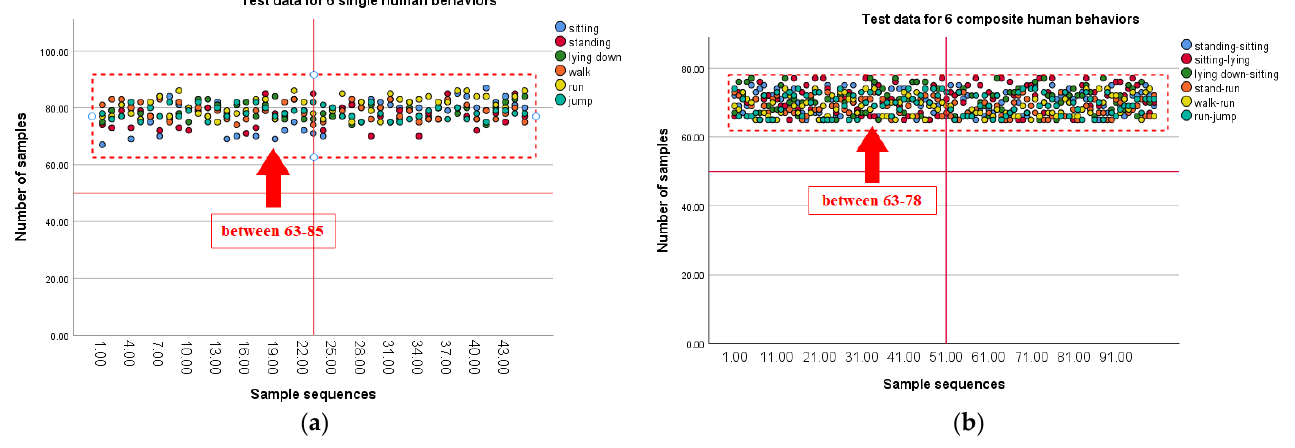
Figure 24. ( a ) A line chart of machine learning detection under an SPSS ( b ) Line chart of machine learning detection under b SPSS.